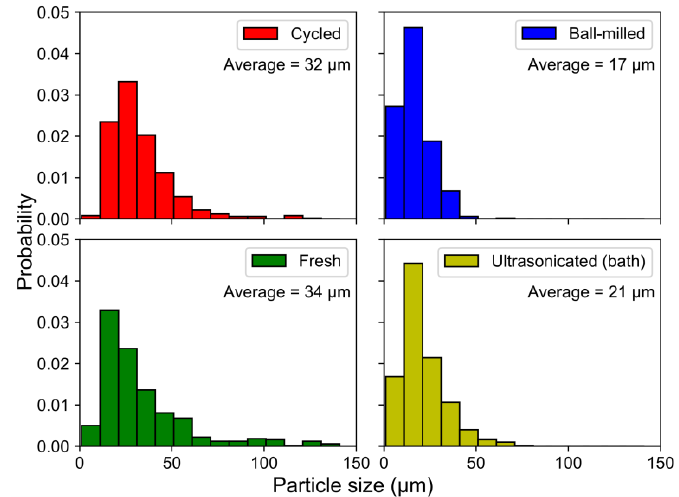
Figure 10. Particle size distributions for the treated/untreated samples, measured by SEM. For each sample, a total of 500 measurements were taken. A significant reduction in the average particle size can be seen for the treated materials. Molecules 2020 , 25 , x